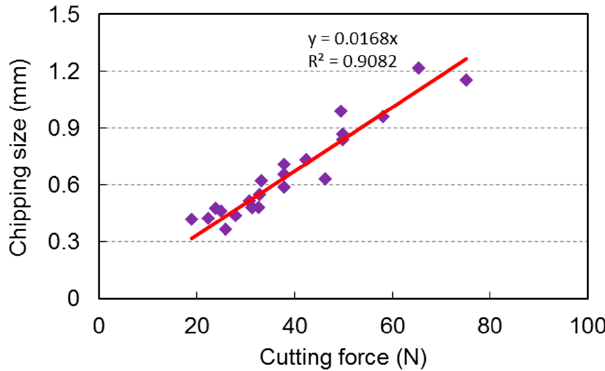
Figure 9. Relationship between cutting force and chipping size.